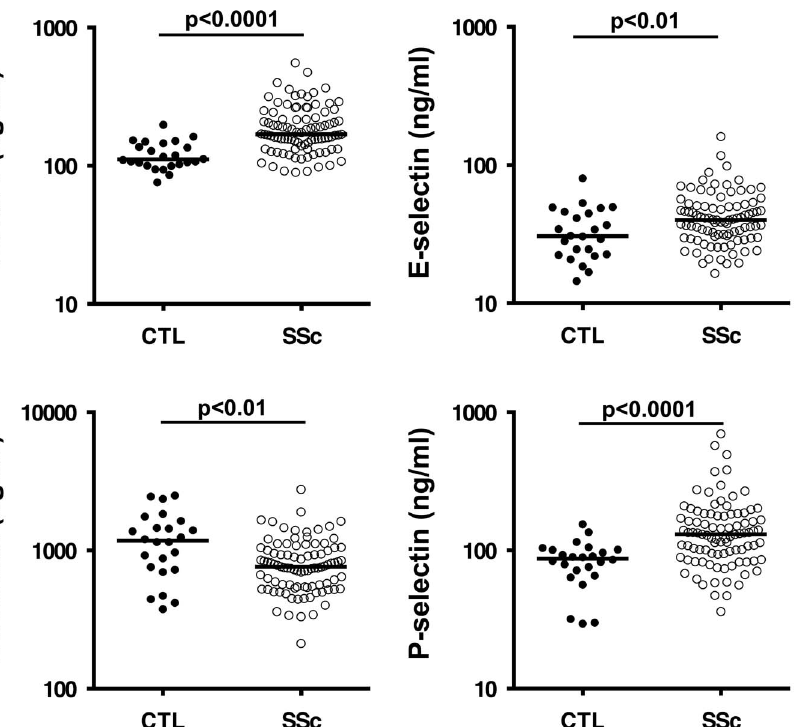
Figure 1. Serum adhesion molecule levels in healthy controls (CTL) and early systemic sclerosis (SSc) patients with diffuse skin sclerosis and/or interstitial lung diseases. The horizontal bar in each group indicates the median value.